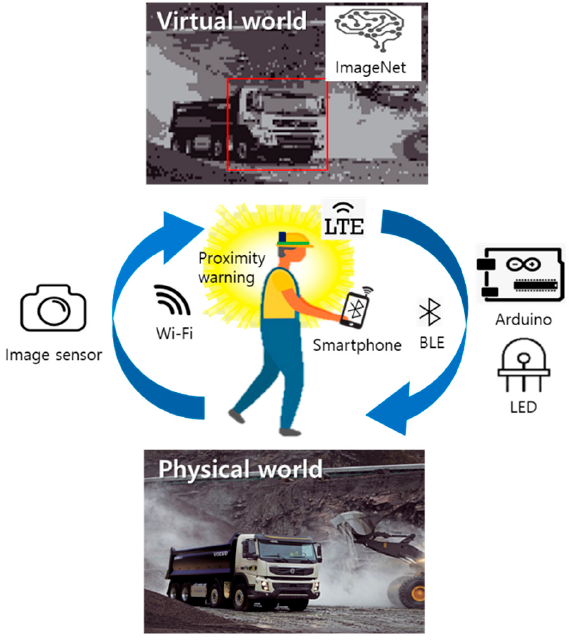
Figure 1. Overview of the AI-based smart helmet proximity warning system.